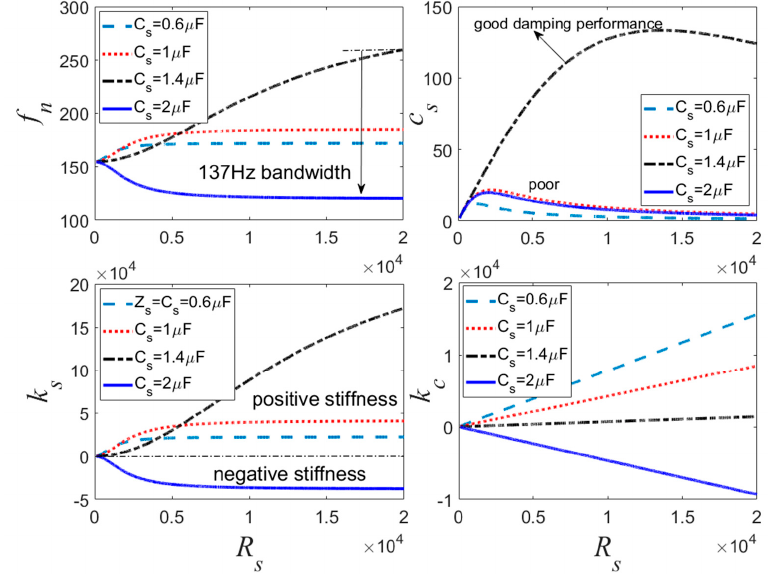
Figure 7 . Controlled stiffness analysis for the negative capacitance in parallel with R s shunt. Figure 7. Controlled sti ff ness analysis for the negative capacitance in parallel with R s